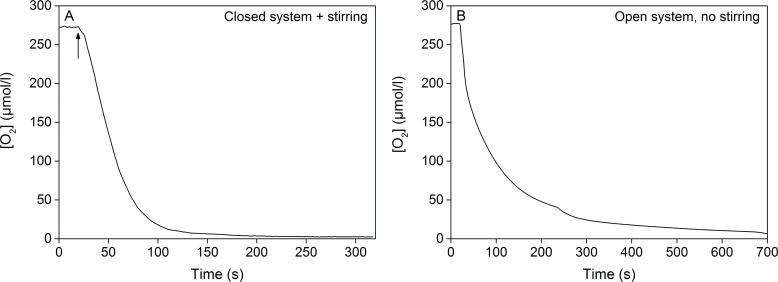
Oxygen consumption by the glucose oxidase system (eight units/ml glucose oxidase, 6 mM glucose and 800 units/ml catalase) in room temperature.(A) Oxygen concentration in 250 ml of ASW medium inside a sealed bottle with minimal head space, stirred with a magnet, before and after the addition of glucose oxidase. The arrow indicates the point where the last component of the glucose oxidase system (glucose oxidase) was added into the mixture, after which the bottle was sealed. (B) Oxygen concentration in 2 ml of ASW medium in an open cuvette without any stirring. The glucose oxidase system had been activated in a separate, sealed 5 ml vial 5 min prior to pipetting 2 ml of the activated mixture into an empty measuring cuvette. Oxygen concentration in (A) and (B) was measured with an optode-type oxygen meter FireStingO2 (PyroScience GmbH, Aachen, Germany) using optically isolated oxygen sensor spots according to manufacturer’s instructions.